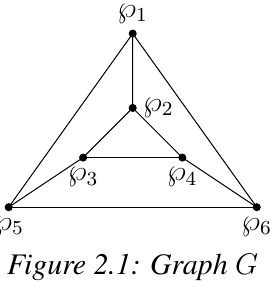
Figure 2.1: Graph